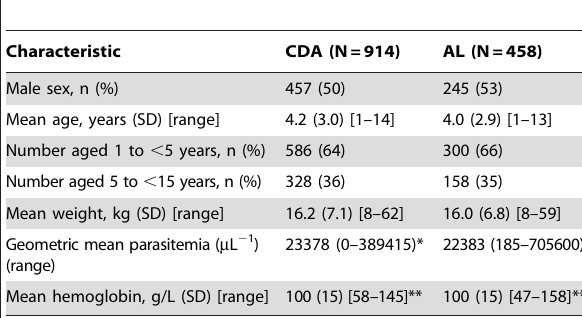
Table 1. Demographic and baseline clinical characteristics of the randomized (ITT) population.